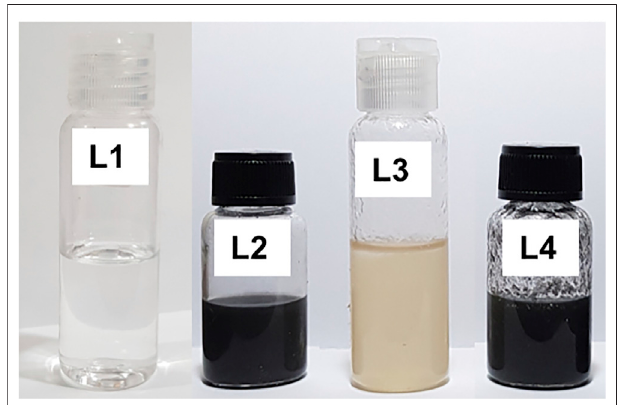
FIGURE 1 | Lubricant specimens: L1 (POE oil), L2 (POE oil + graphene), L3 (POE oil + BC particles), L4 (POE oil + BNC particles +